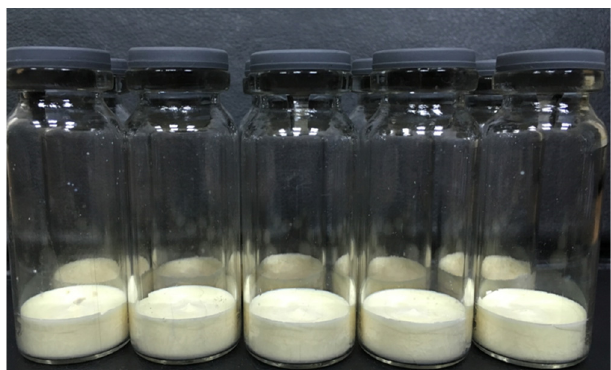
Figure 3. Typical freeze-dried cakes of Pz formulations with excipients in vials.